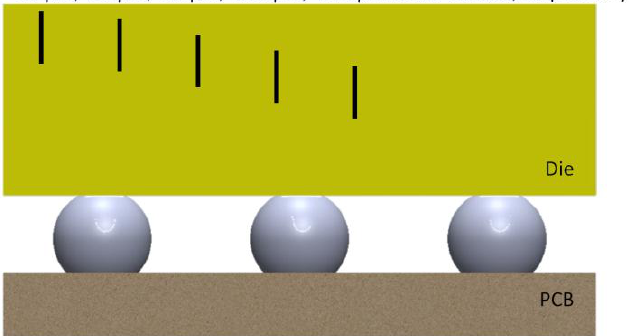
Figure 12. Schematic showing different crack locations.